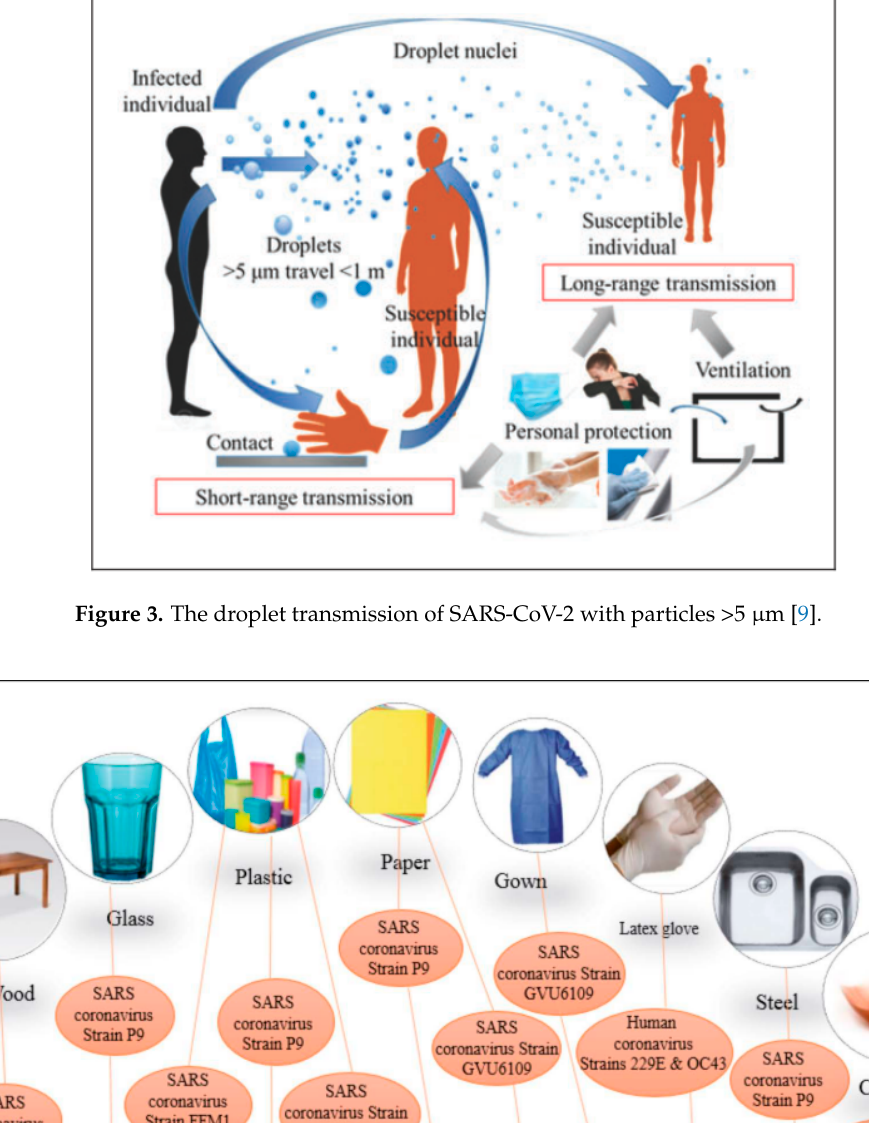
Figure 3. The droplet transmission of SARS-CoV-2 with particles >5 µm [9].